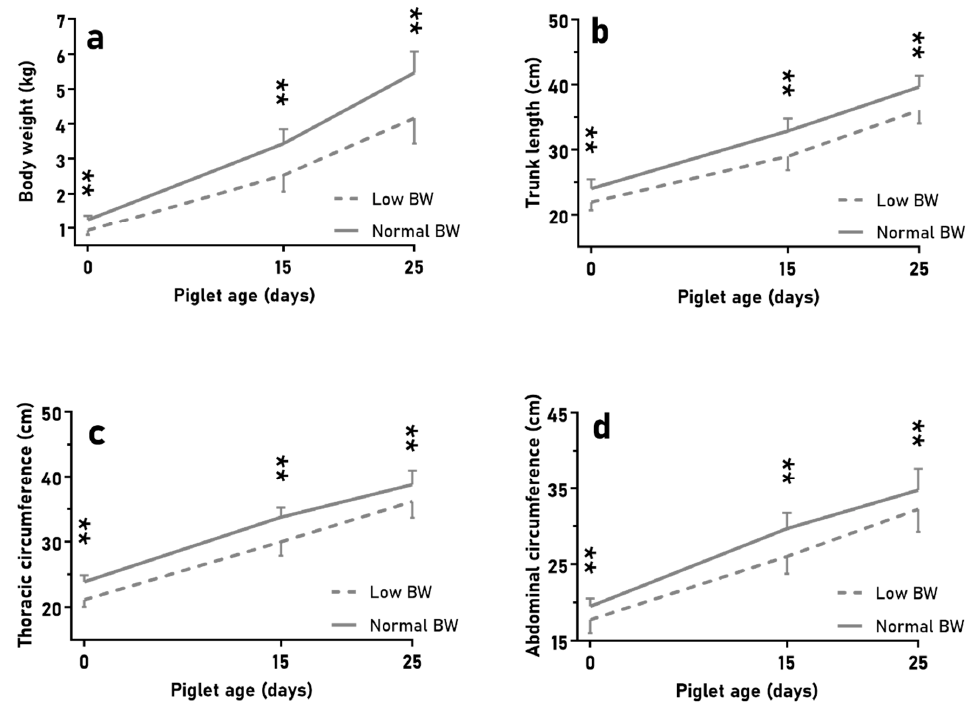
Figure2. Meanvalues( ± SD)ofbodyweight( a ),trunklength( b ),andthoracicandabdominalcircumferences Figure 2. Mean values (±SD) of body weight ( a ), trunk length ( b ), and thoracic and abdominal ( c , d ) over time of lactation when comparing low birth-weight(BW) ( n = 18) vs. normal BW piglets ( n = 38) circumferences ( c ) and ( d ) over time of lactation when comparing low birth-weight(BW) ( n = 18) vs. in large litters. Asterisks indicate significant differences (** p < normal BW piglets ( n = 38) in large litters. Asterisks indicate significant differences (* p < 0.05, ** p < 0.01).